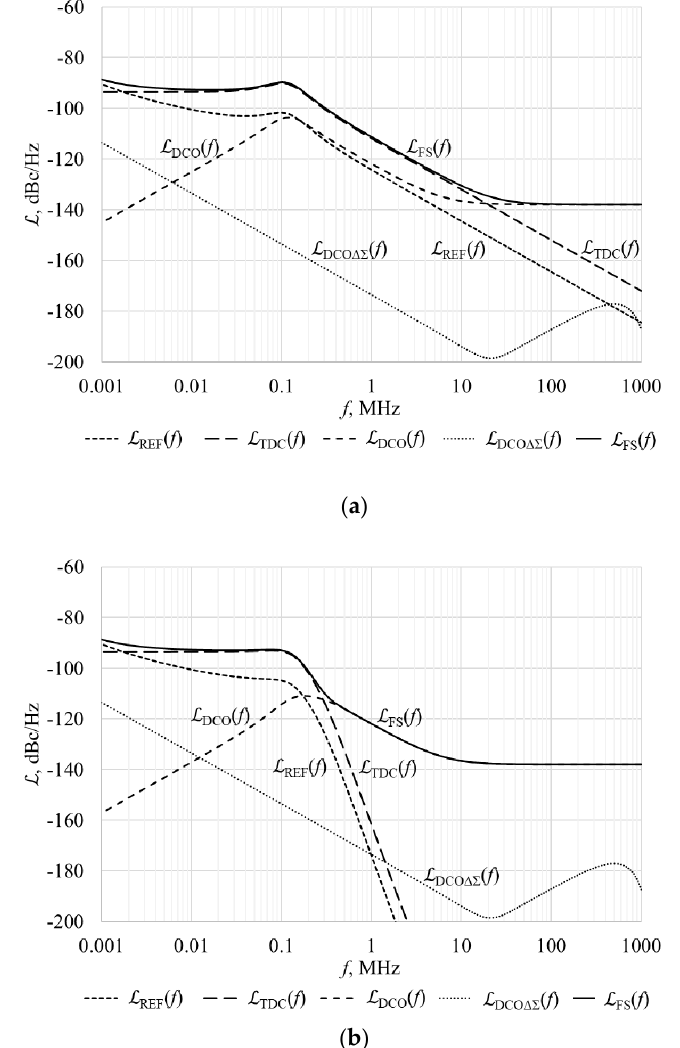
Figure 2. Calculated phase noise and its components of an all digital frequency synthesiser, when ∆ f f DCO = 5.38 GHz, f REF = 48 MHz, f ΔΣ = f DCO /4, Δ f RES = 26 kHz, W = 9, n = 2 with two filter configurations: = 5.38 GHz, f REF = 48 MHz, f ∆Σ = f DCO /4, RES = 26 kHz, W = 9, n = 2 with two filter